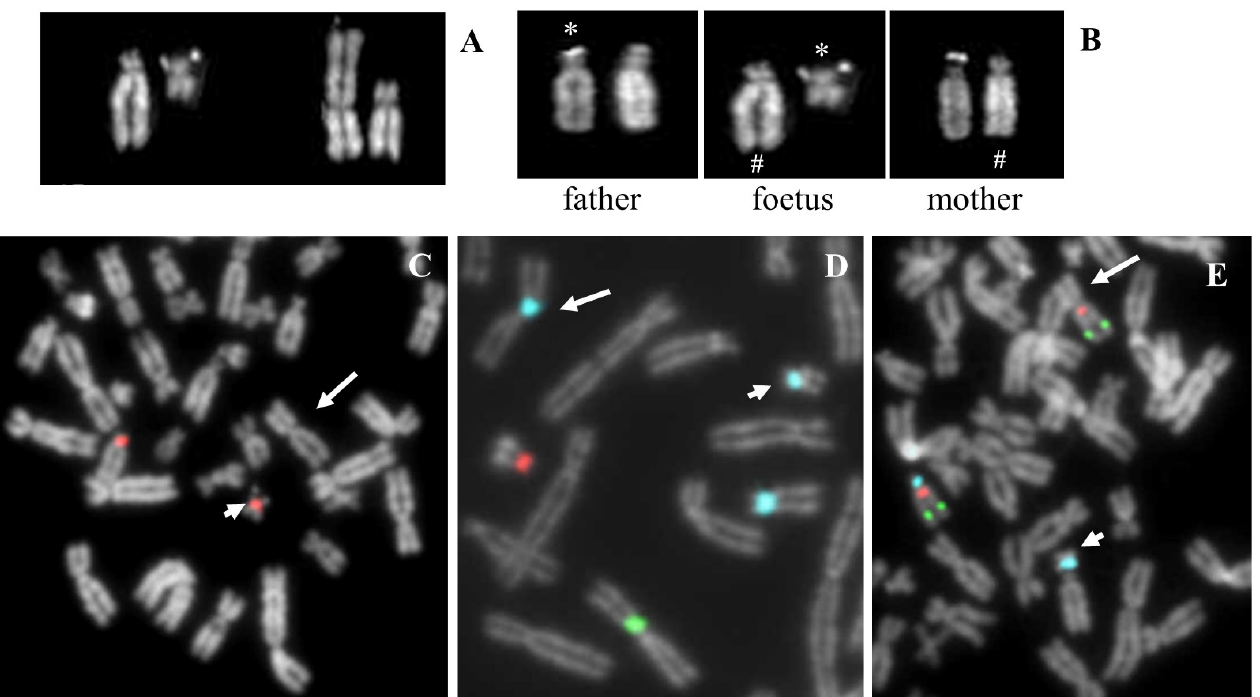
Figure 4. Case 4. ( A ) QFQ banded chromosomes 15 and 18 of the proband. From left to right: normal 15, derivative 15, derivative 18 and normal 18. ( B ) QFQ banded chromosomes 15 of the father ( left ), the foetus ( middle ) and the mother ( right ). #: indicates the normal chromosome 15; *: indicates the satellites of the paternal chromosome. ( C ) FISH with probe D15Z4, centromeric, alpha satellite, the arrow indicates the derivative 18 without signal of hybridization. ( D ) Multicolour FISH with probes D18Z1 (light blue) DXZ1 (green) DYZ3 (red). The arrow indicates the derivative 18 and the arrowhead indicates the derivative 15. ( E ) Multicolour FISH with probes D15Z1 (15p11.2, satellite III, light blue), SNRPN (15q11.2, red), PML (15q24, green). The arrow indicates the derivative 18 and the arrowhead indicates the derivative 15.